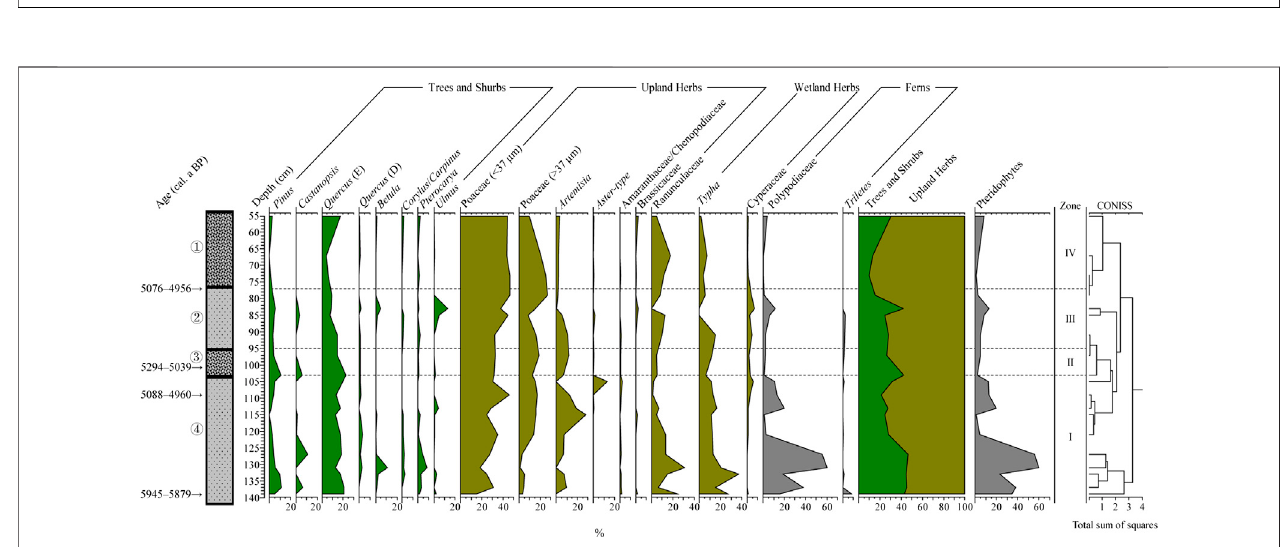
FIGURE 3 | Sporopollen percentage of the Hejia Site. ① the late Liangzhu Culture to the Qianshanyang Culture Period, ② the middle Liangzhu Culture Period, ③ the early Liangzhu Culture Period, and ④ the Hemudu Culture Period Ⅳ .